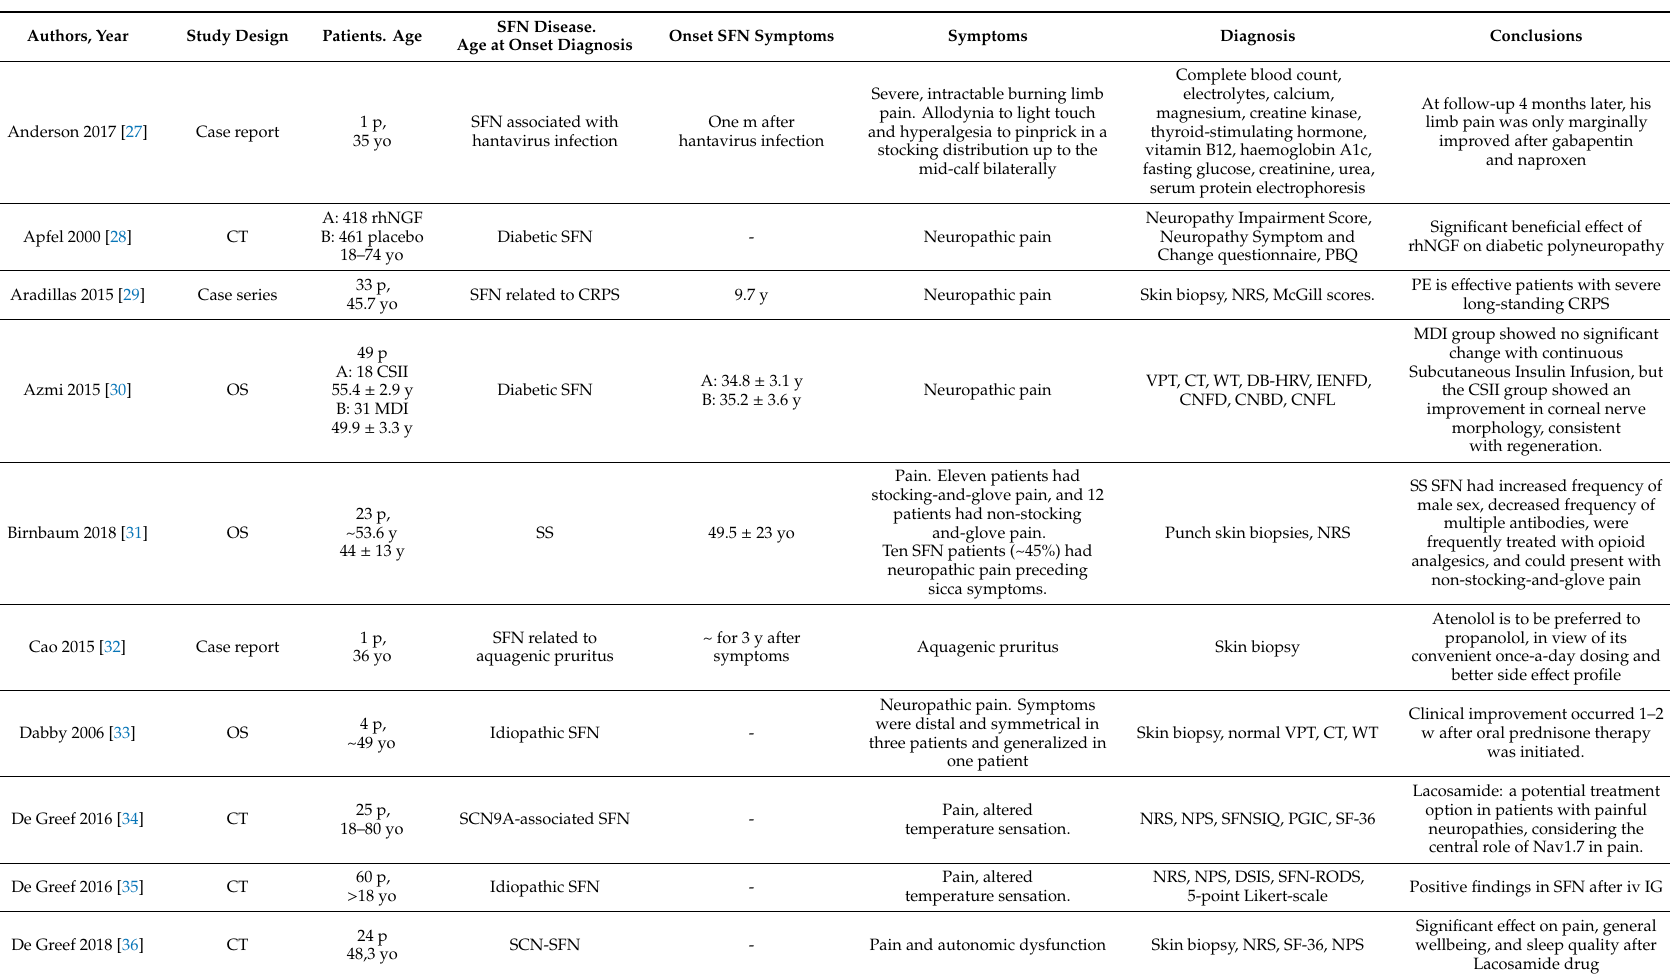
Table 1. Diagnostic methods of small fiber neuropathy (SFN). Characteristics and outcomes of studies included in the systematic